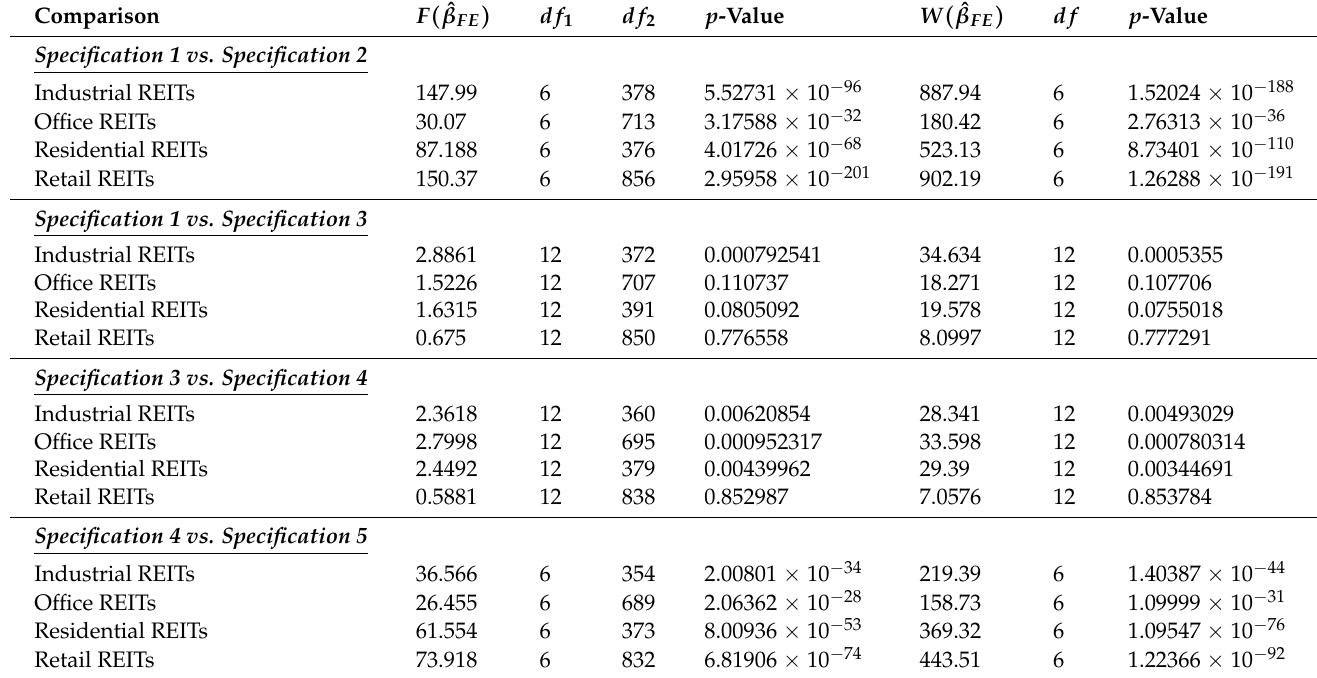
Table 4. Model Selection.